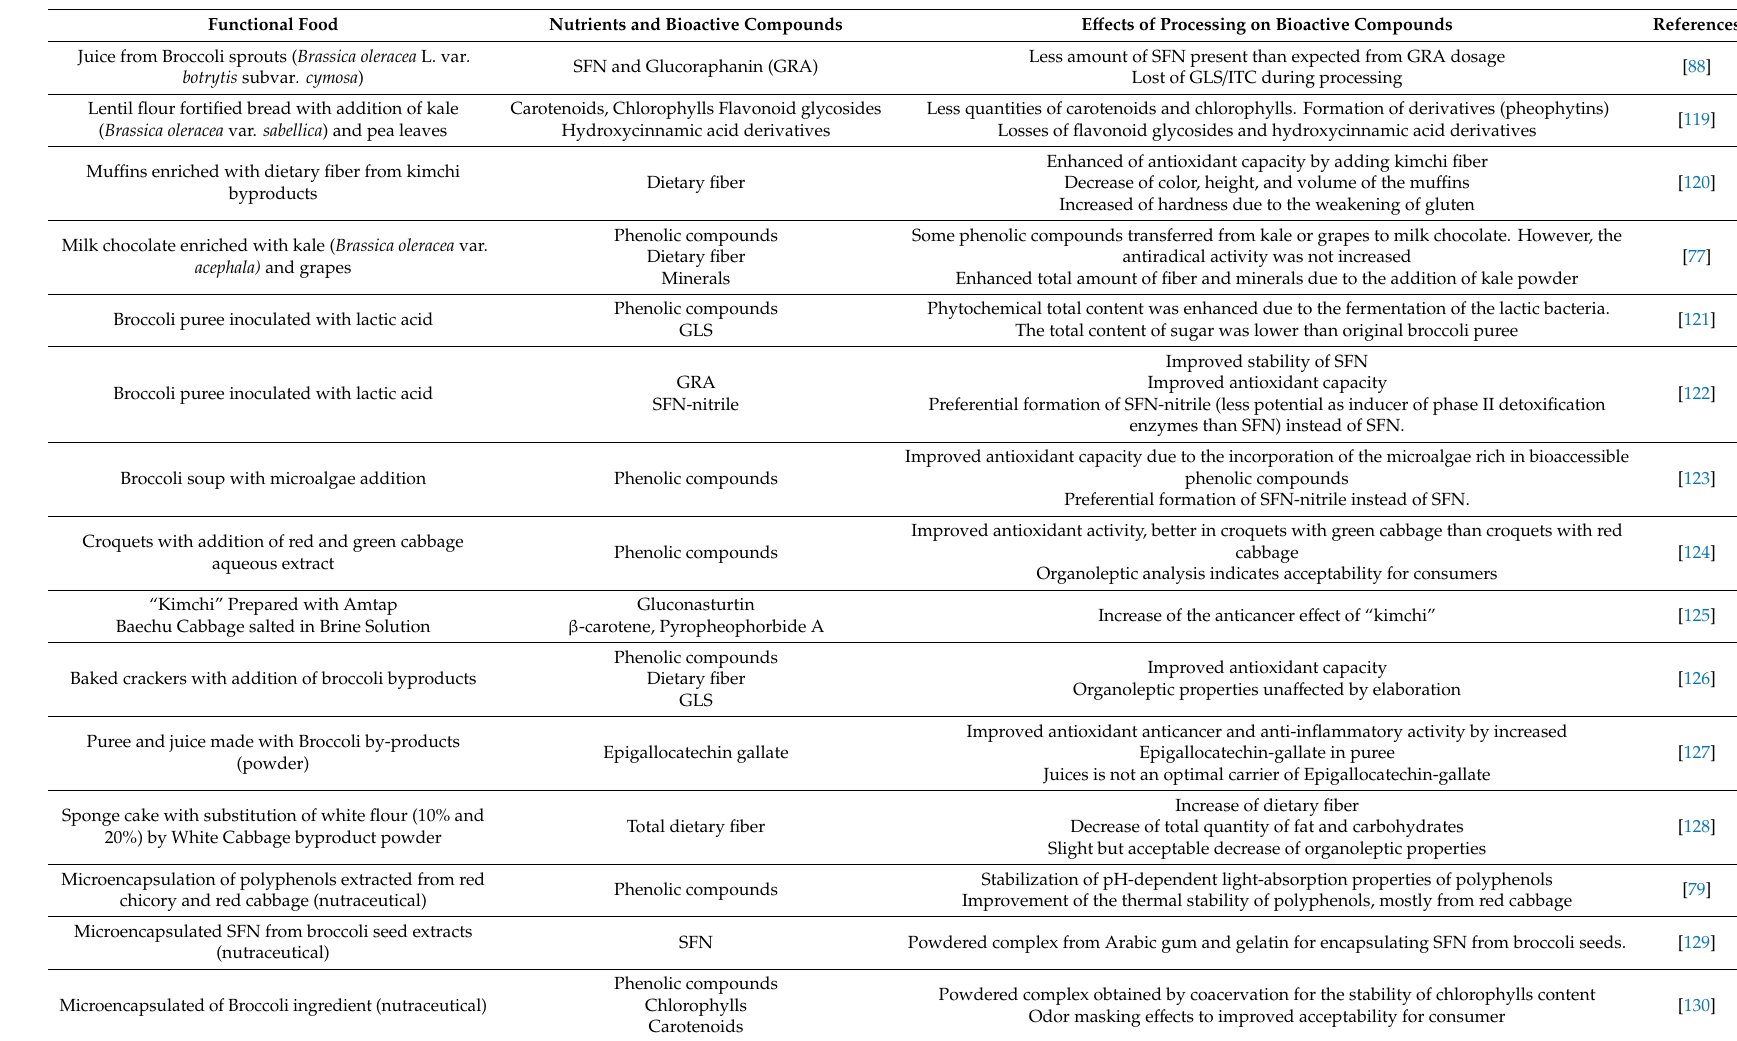
Table 2. Diverse experimental products based on functional ingredients from Brassicaceae